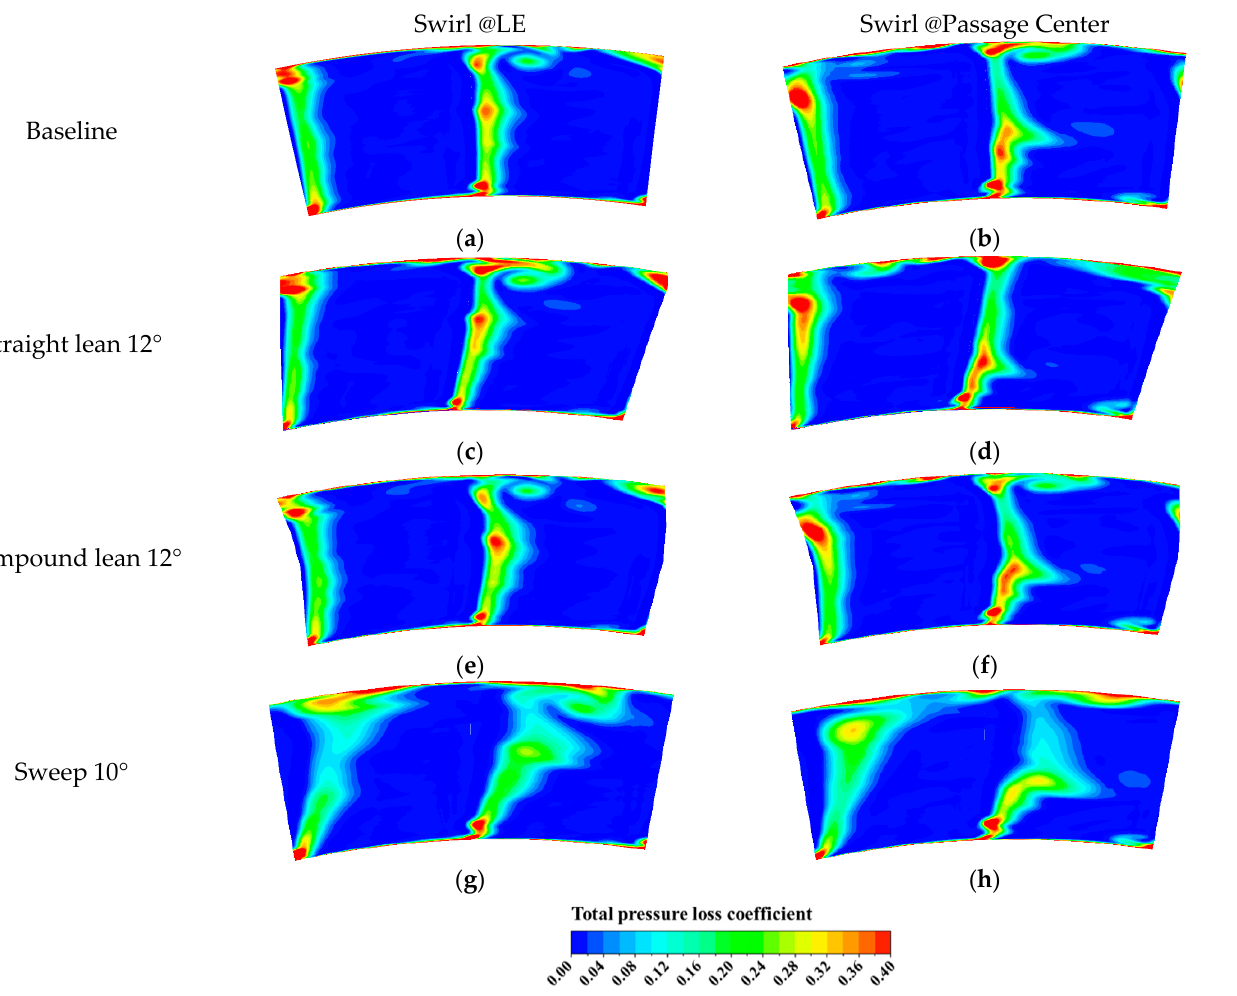
Figure 23. Total pressure loss coefficient at vane exit, z/C ax =1.06 (rear view): ( a ) SL0 SP0 SW@LE; ( b ) SL0 SP0 SW@PC; ( c ) SL12 SP0 SW@LE; ( d ) SL12 SP0 SW@PC; ( e ) CL12 SP0 SW@LE; ( f ) CL12 SP0 SW@PC; ( g ) SL0 SP10 SW@LE; ( h ) SL0 SP10